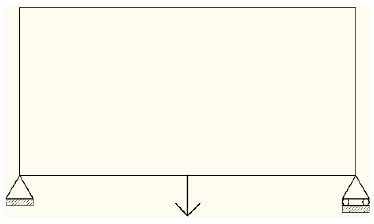
Figure 9. Simplified model of half-wheel beam.